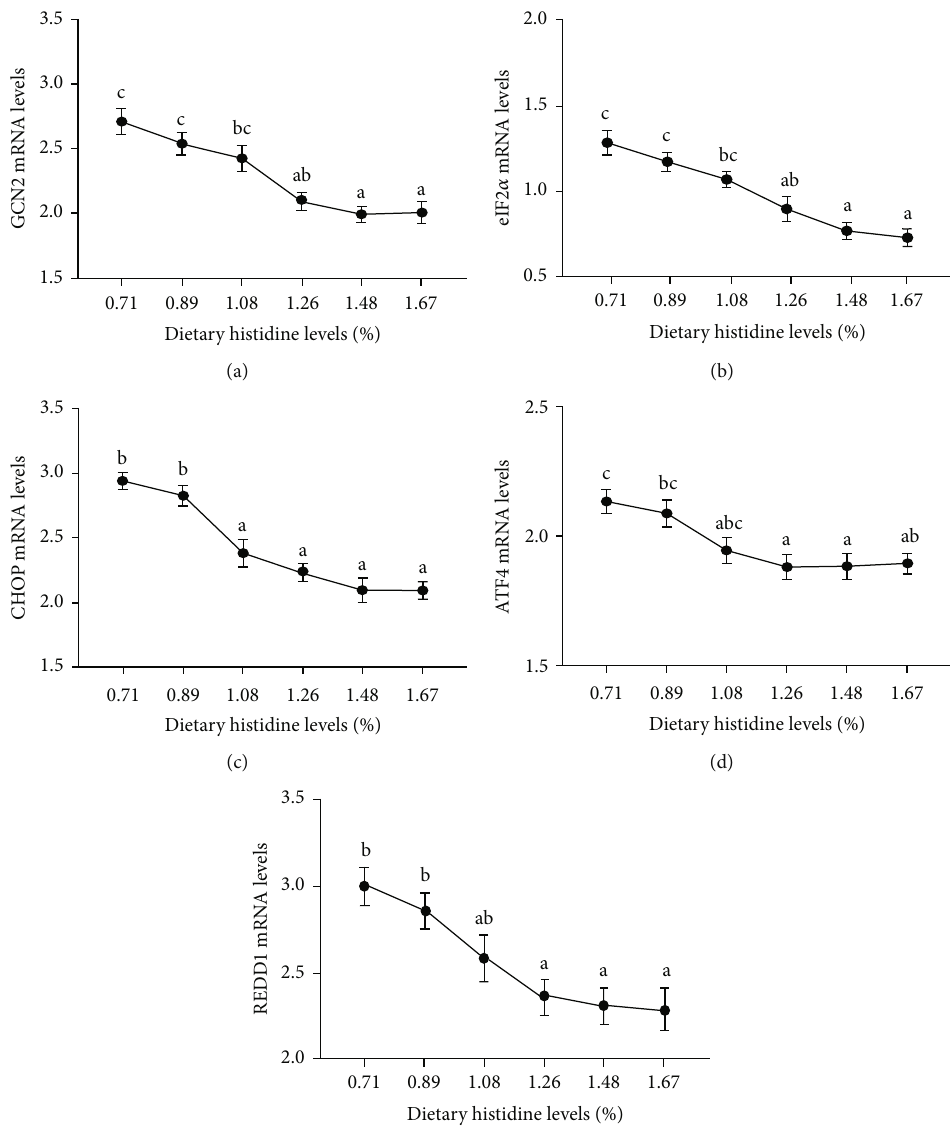
Figure 6: The relative expressions of AAR signaling pathway in liver of juvenile largemouth bass fed with di ff erent levels of dietary histidine. Data are expressed as means with S.E.M.; value with di ff erent superscripts are signi fi cantly di ff erent ( P < 0 : 05